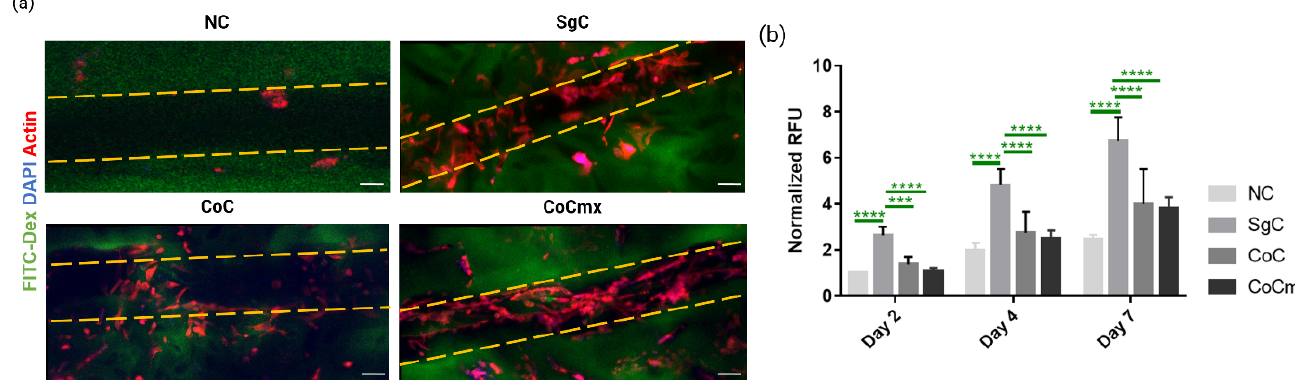
Figure 7. Cell analysis of seeded HUVECs on non-functionalized (NC) and functionalized scaffolds with a different spatial distribution of Caf1-YIGSR and Caf1-VEGF (SgC, CoC, and CoCmx) via the DFD method. ( a ) Images represent Z-Projection (average intensity) showing cell morphology at day 7 via CLSM. Scale bar = 100 µ m. Yellow dashed lines represent the limit of the microchannel; ( b ) Cell metabolic activity (resazurin-based assay) at days 2, 4, and 7. Statistical analysis using two-way ANOVA of all hydrogels compared to SgC. Statistical analysis was performed using a two-way ANOVA. *** p < 0.001, **** p < 0.0001.